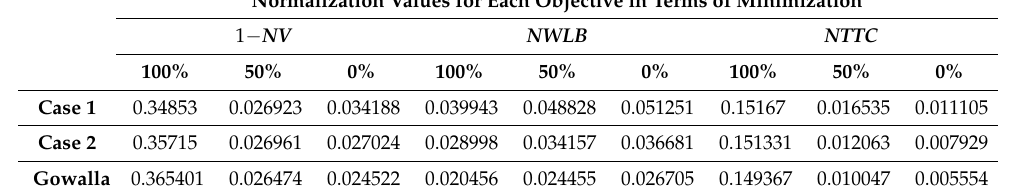
Table 9. Normalization values of the objectives in terms of minimization when varying the initializa- tion